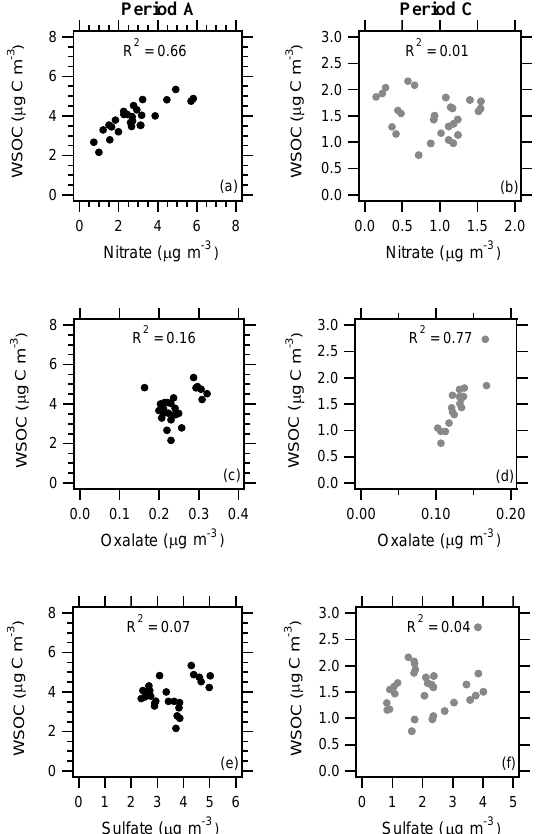
Figure 5. Correlation of hourly averaged WSOC vs. OA for (a) Pe- riod A and (b) Period C, ALW for (c) Period A and (d) Period C, and RH for (e) Period A and (f) Period C at SPC. All plots are for during the times of RH increasing.